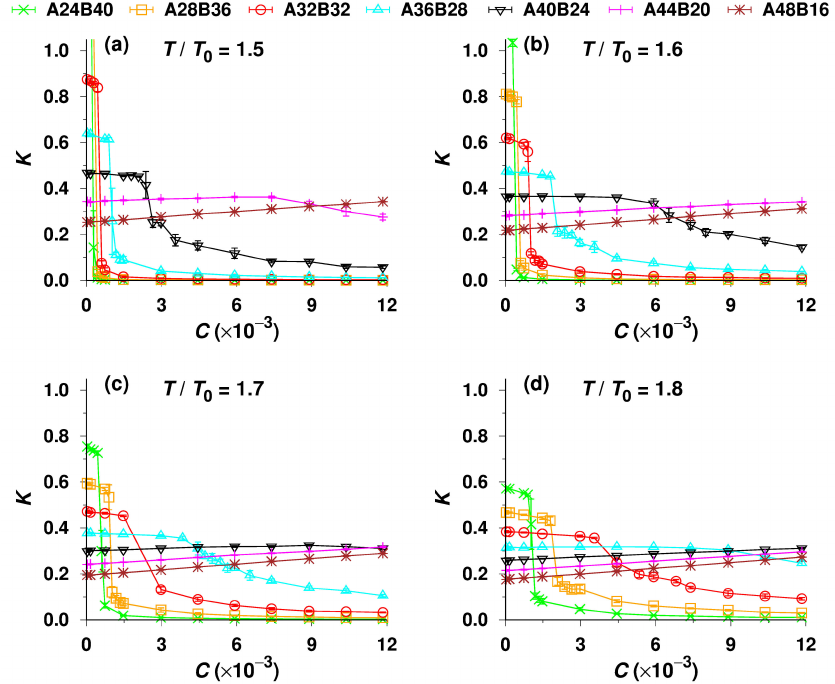
Figure 6. Partition coefficient, K , of seven different AB diblock copolymers as a function of total concentration, C , for the temperatures T / T 0 = 1.5 ( a ), 1.6 ( b ), 1.7 ( c ), and 1.8 ( d ). The pore diameter D = 20, and the inner surface is inert, i.e., (cid:101) WA = (cid:101) WB = (cid:101) WS =